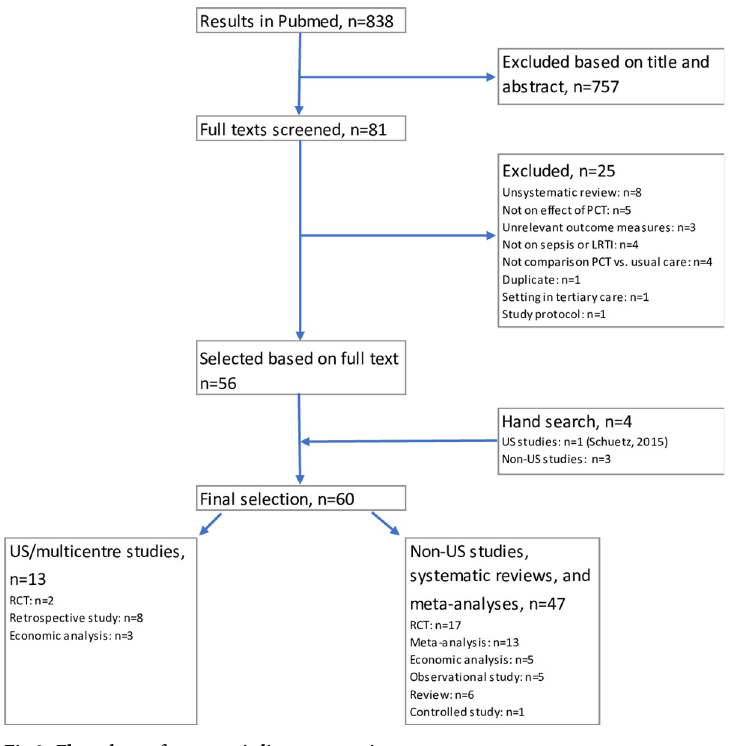
Fig 3. Flow chart of systematic literature